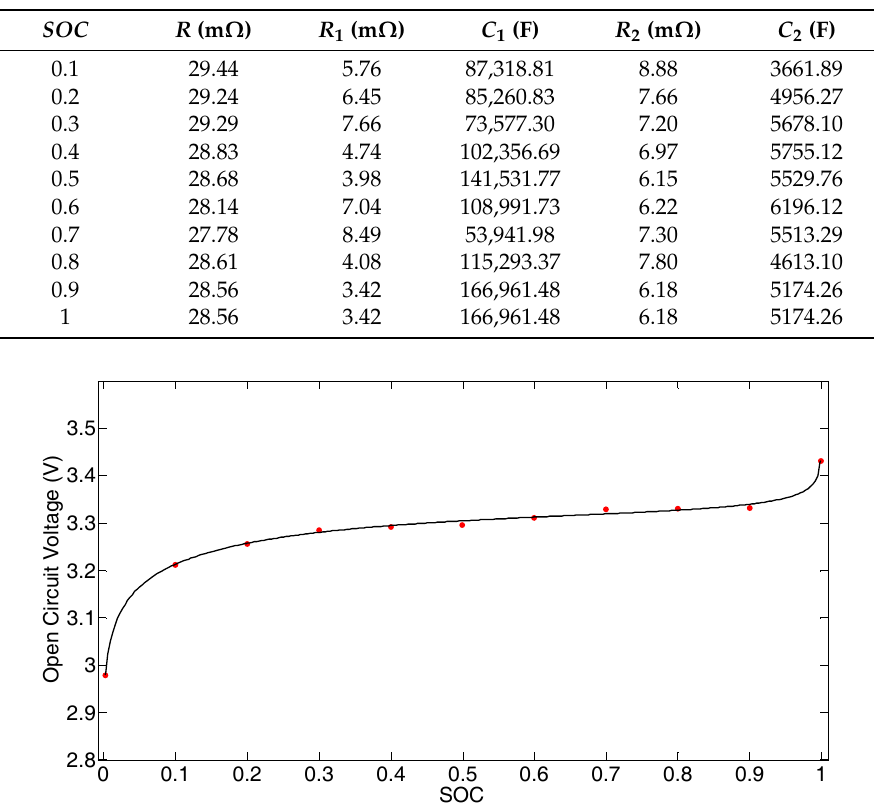
Table 2. The identification result of R , R 1 , C 1 , R 2 and C 2 .